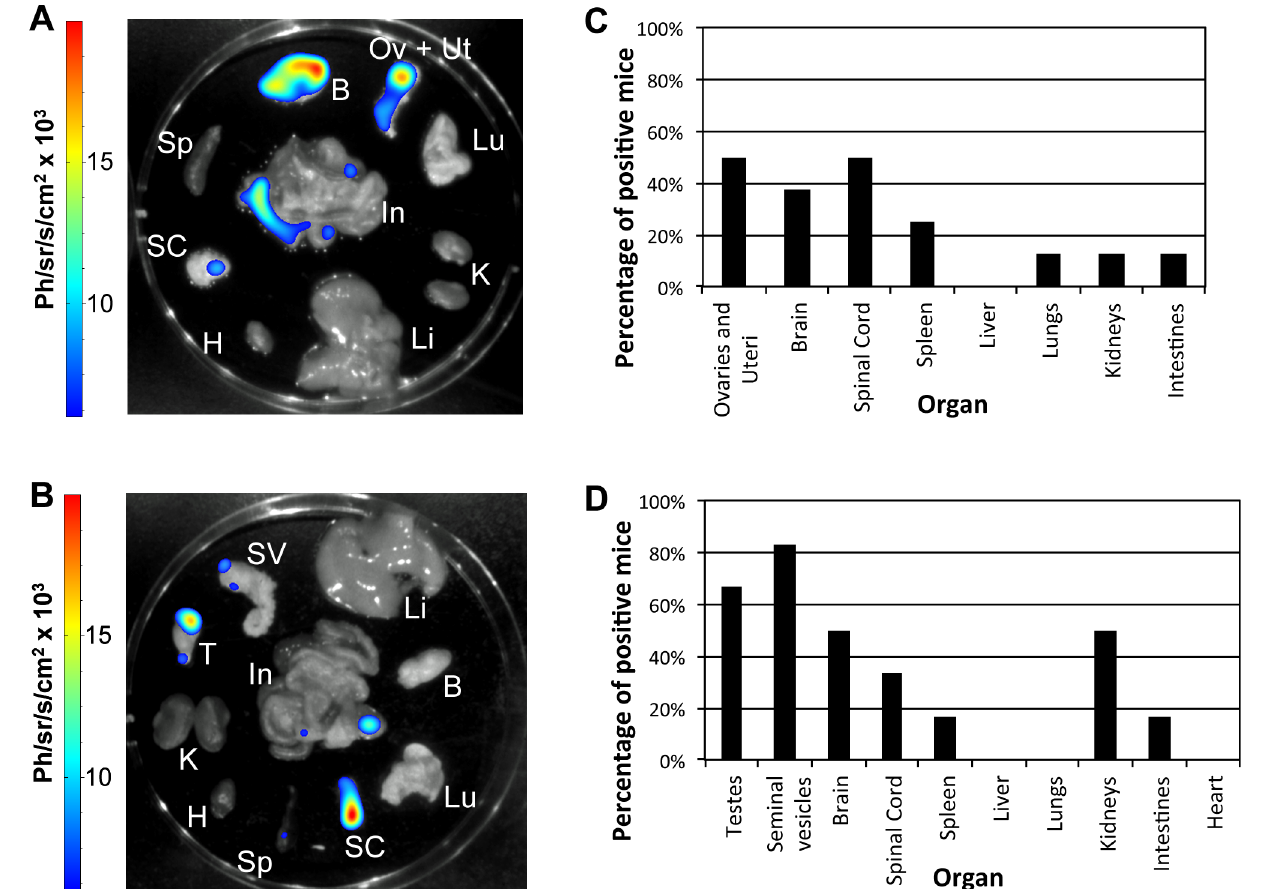
Fig 2. Tropism of T . b . gambiense 1135 (Rluc) in male (n = 6) and female (n = 8) mice infected for 12 – 18 months analysed by bioluminescence. Representative BLI of ex vivo organs of a single infected (A) female (mouse 23797g, see S2 Table) and (B) male (mouse 27711SM, see S2 Table) mouse. The colour scale to the right of the image indicates the colour intensity in ph/sr/cm 2 /s. Ov, ovaries; Ut, uterus; T, testes; SV, seminal vesicles; B, brain; SC, spinal cord; Sp, spleen; Li, liver; Lu, lungs; K, kidneys; In, intestines; H, heart. Percentage of positive (C) female (n = 8) and (D) male mice (n = 6) per organ by